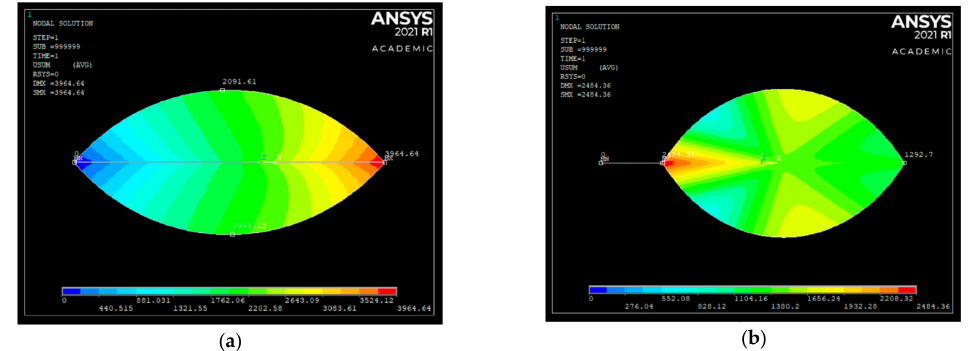
Figure 24. (Above) ( a ) Sliding mechanism post FEM analysis contour plot of the sum of displacements from the highest absolute displacement (in red) to the lowest displacement in the negative direction (displayed in um). ( b ) Zipping mechanism post FEM analysis contour plot of the sum of displacements from the highest absolute displacement (in red) to the lowest displacement in the negative direction (displayed in